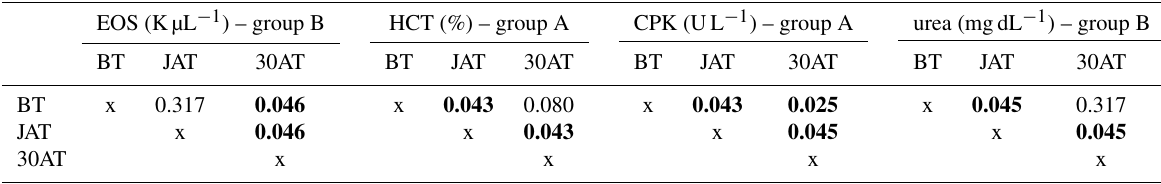
Table 3. Multiple comparisons of the mean ranks for all groups ( p values) before the training on the treadmill (BT), just after the train- ing (JAT) and 30min after the training (30AT).